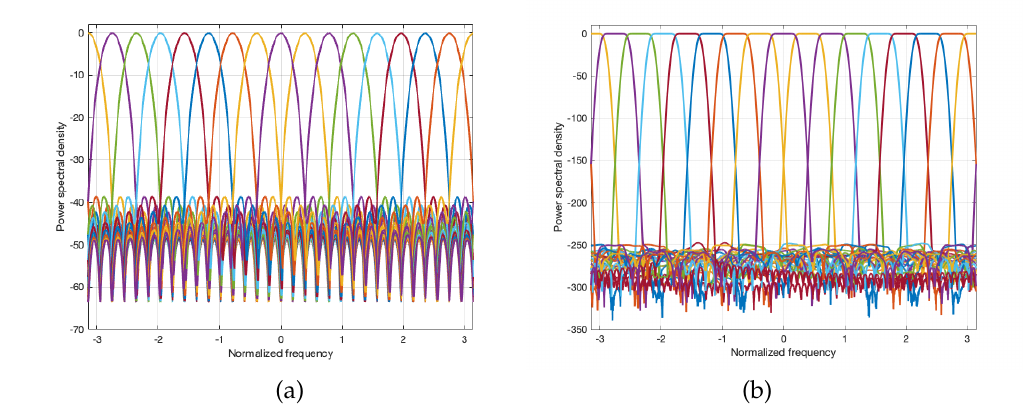
Figure 4. Power spectral density of filter banks with 16 subchannels: ( a ) Discrete Fourier transform (DFT) filter bank and ( b ) near-perfect reconstruction (NPR) polyphase filter